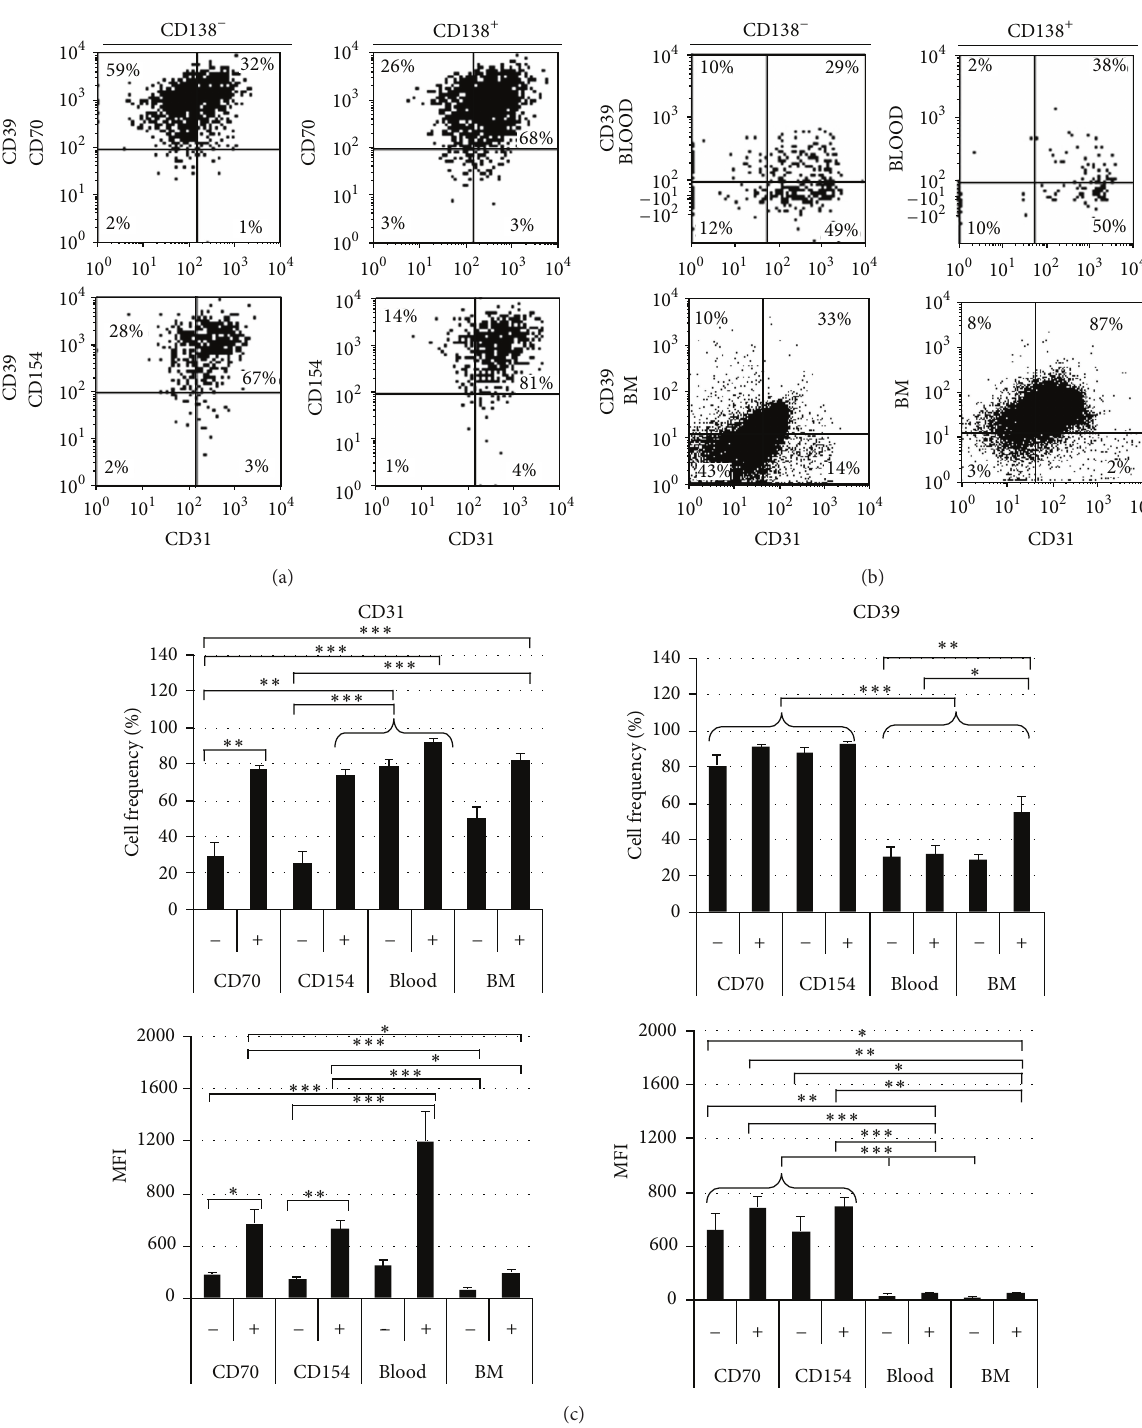
Figure 6: CD31 as an in vivo and in vitro generated plasma cell marker. Analyses were done on cells submitted to 14 days in differentiation conditions. (a) D14 viable CD 38 hi cells were analyzed based on their CD31 and CD39 expression. Plots are representative of 10 independent experiments for the CD70 interaction and 13 for the CD154 interaction. (b) Bone marrow and peripheral blood plasma cells (viable CD45 + CD 38 hi ). Plots are representative of 10 and 14 independent experiments for bone marrows and for peripheral blood, respectively. (c) Comparison of CD31 and CD39 expression and frequency on generated (CD70 and CD154) and in vivo (PB and BM) plasma cells. CD138 − ( − ) and CD138 + (+) plasma cells expression profiles were compared using the Unpaired 𝑡 - or the Mann-Whitney test ( ∗ indicating a significant difference with 𝑃 values < 0.03). The expression profile of CD138 − ( − ) cells from different origins was compared ( ∗∗ indicating significant differences with 𝑃 values < 0.02) as well as CD138 + (+) plasma cells ( ∗∗∗ indicating significant differences with 𝑃 values < 0.006) using the Kruskal-Wallis